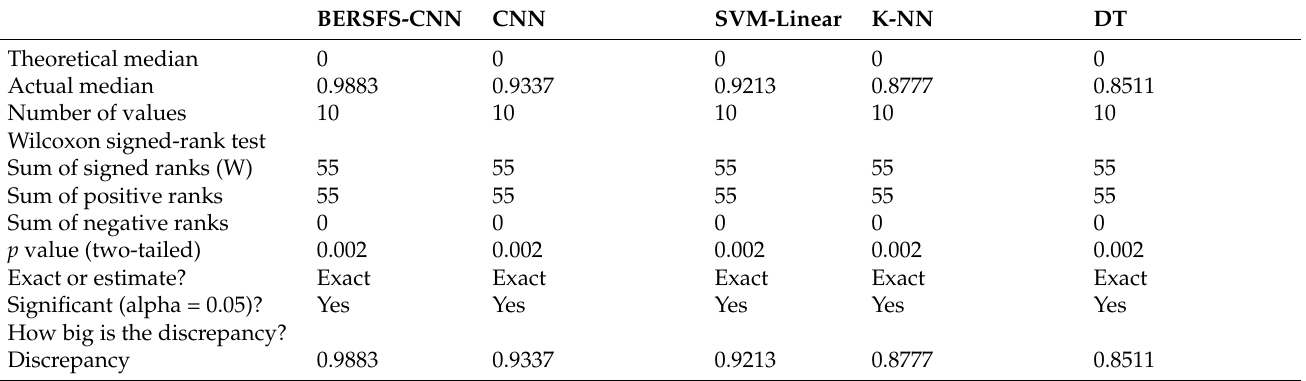
Table 6. Test results for the Wilcoxon signed-rank test of the BERSFS-CNN model and basic